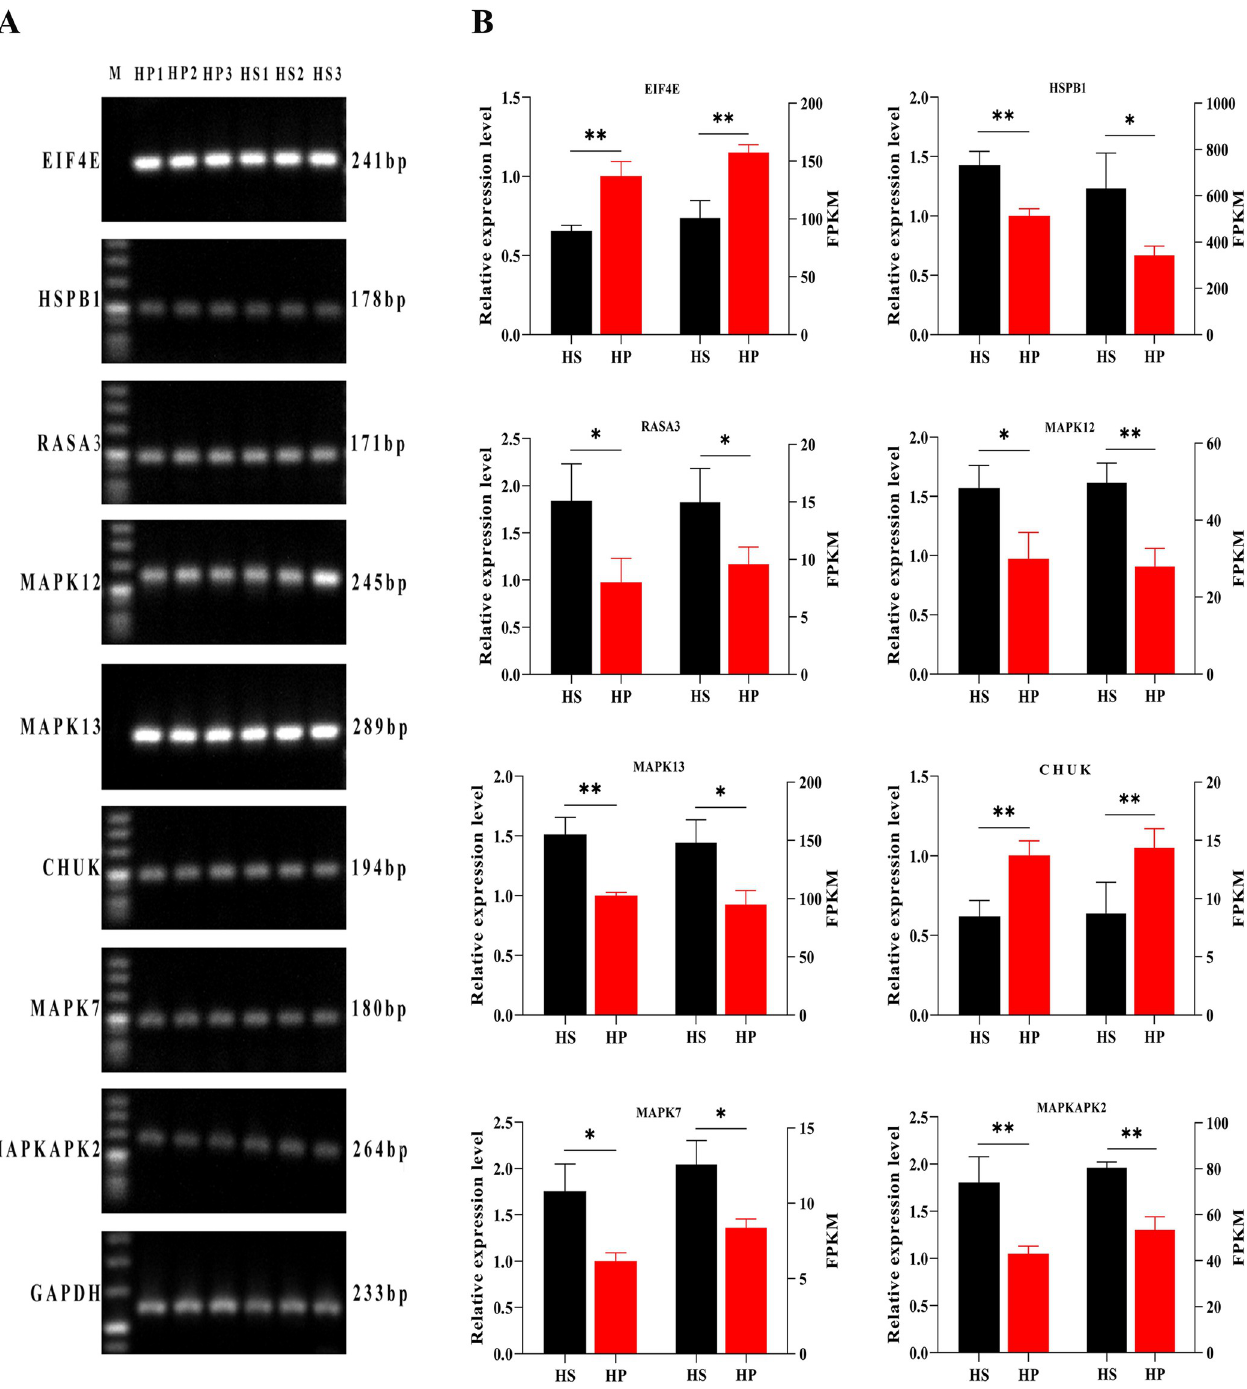
Fig 7. Eight genes selected for qPCR verification. ( A ) Electropherogram of the test genes and the internal reference gene ( GAPDH ). ( B ) Eight genes for qPCR detection and RNA-seq results. The left axis of the histogram represents the gene expression level, and the right axis of the histogram represents the FPKM value of the sequencing data. HS refers to the skin in the high wool density group, and HP refers to the skin in the low wool density group. ( � p < 0.05 and �� p <